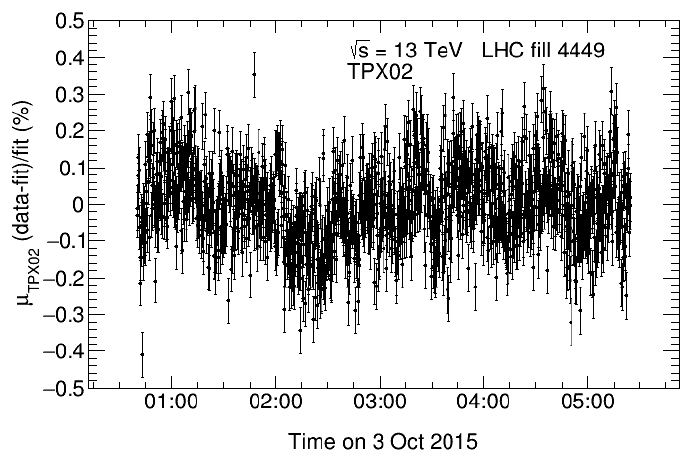
Figure 38. Relative difference between the data and the fitted average number of interactions per bunch crossing as a function of time, seen by TPX02 averaged over layers 1 and 2. The data are shown for 10 frames (1s each) combined in order to decrease the statistical uncertainty. LHC fill 4449. Taken from Ref. [14].